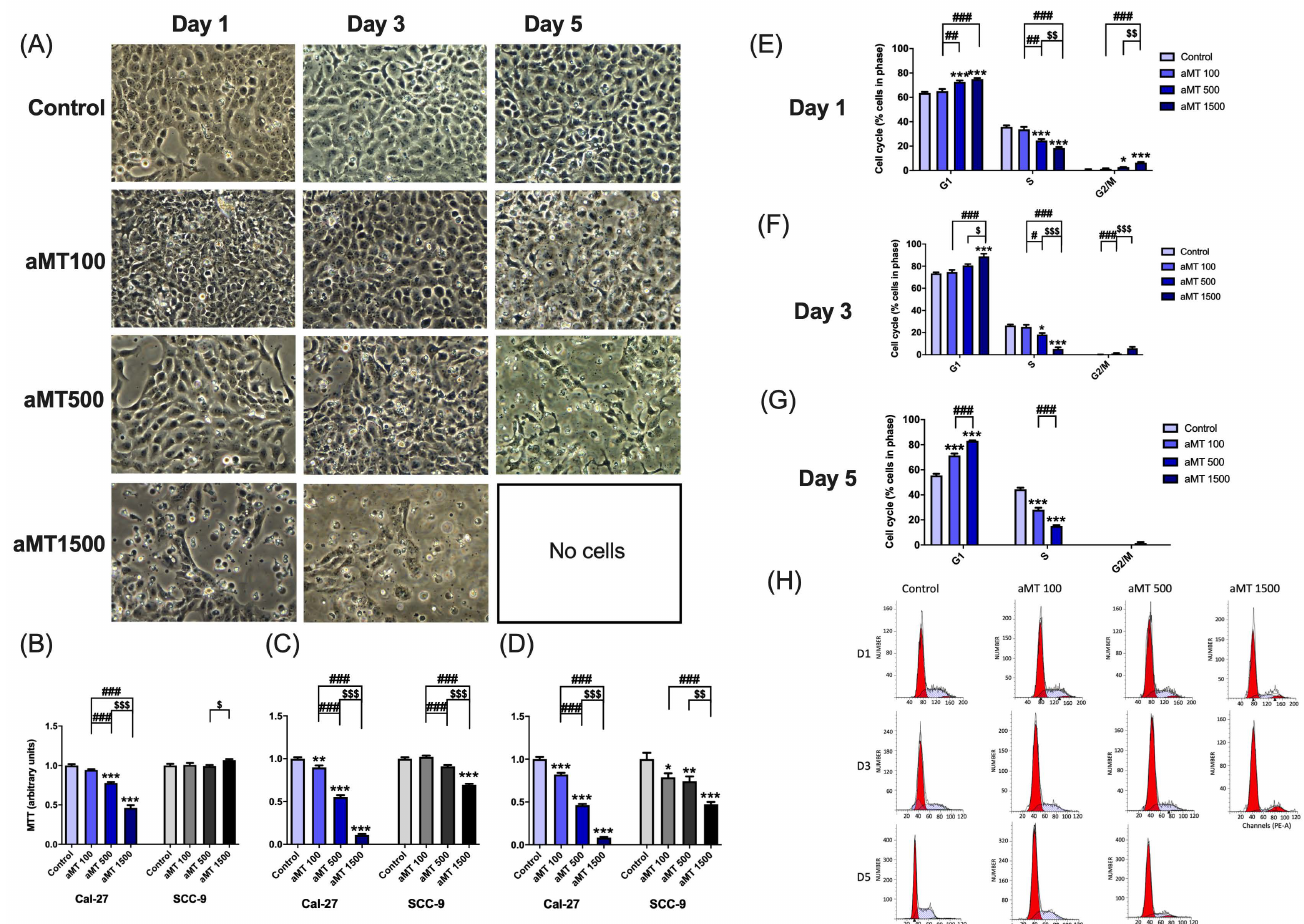
Figure 9. Decreased proliferation of Cal-27 and SCC-9 cells caused by melatonin. Morphological alterations ( A ), proliferation rate ( B – D ), percentage of cells in each cell cycle phase ( E – G ), and representative plots showing cell redistribution ( H ). Data for aMT 1500 group are not shown at day 5 because most cells died. n = 6 per group. Data are presented as mean ± SEM. * p < 0.05, ** p < 0.01, *** p < 0.001 vs. control; ## p < 0.01, ### p < 0.001 vs. aMT 100 µ M group; $ p < 0.05, $$ p < 0.01, $$$ p < 0.001 vs. aMT 500 µ M